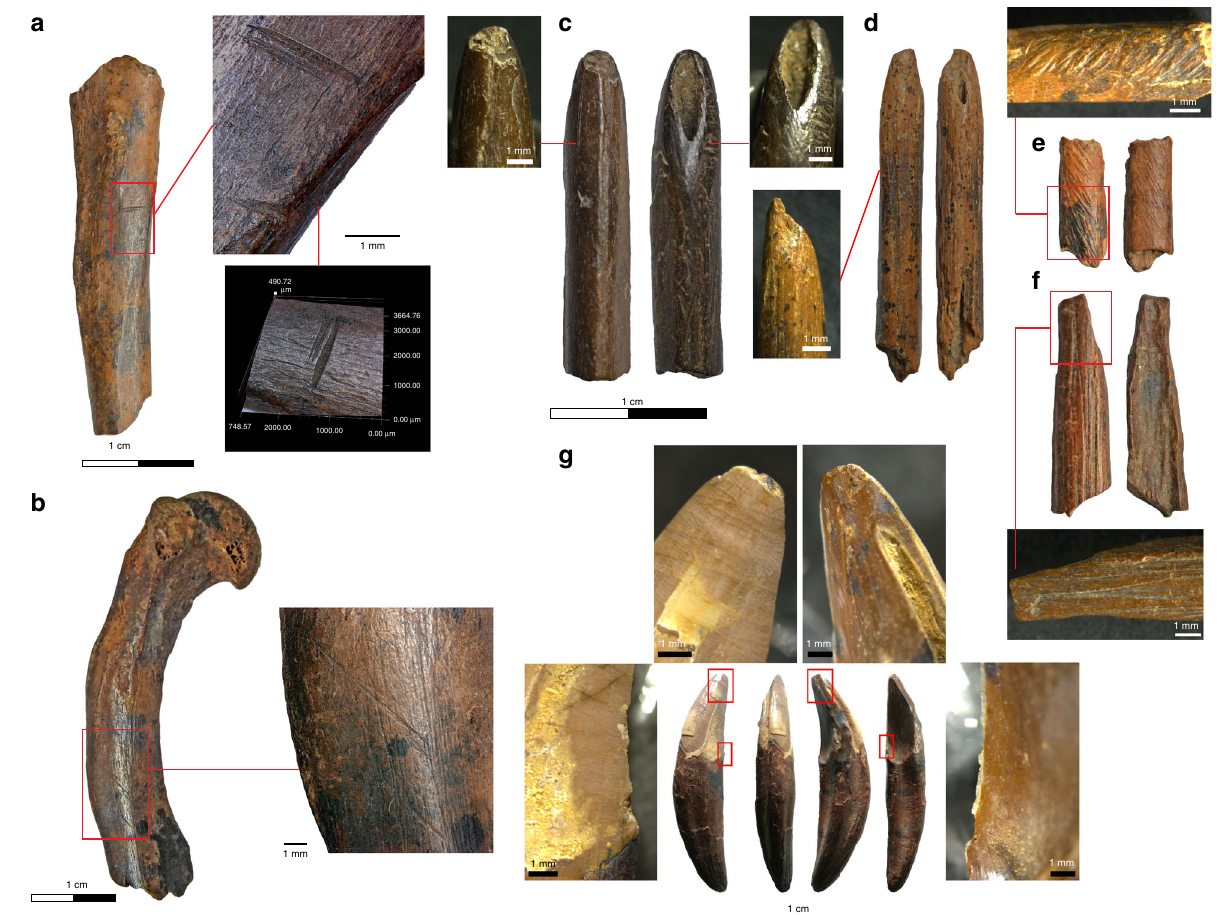
Fig. 4 Specimens with anthropic modi fi cations from the Late Pleistocene layers of Fa-Hien Lena. Bone fragments with evidence for butchery and osseous tools and artifacts from the earliest phase of occupation at Fa-Hien Lena. a Cutmarks on a grizzled giant squirrel ( Ratufa ) tibia. b Cutmarks on an otter ( Lutra ) humerus. c , d Cercopithecid monkey fi bula points with evidence for shaping (ground) before high-pressure tip use. e Monkey distal fi bula shaft fragment with grinding marks. f Worked monkey femur shaft fragment. g Worked macaque canine showing damage from use in cutting (on sides) and pressure/piercing on